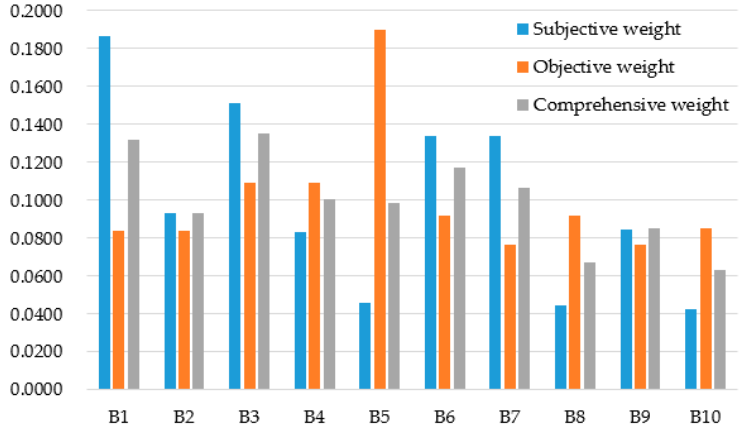
Figure 7. The weights of each evaluation indicator.